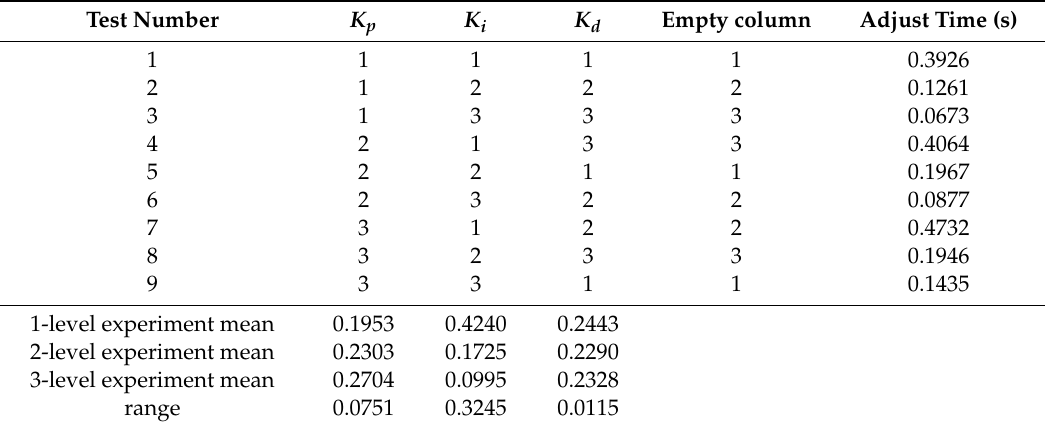
Table 7. Data table of PID orthogonal experimental results.